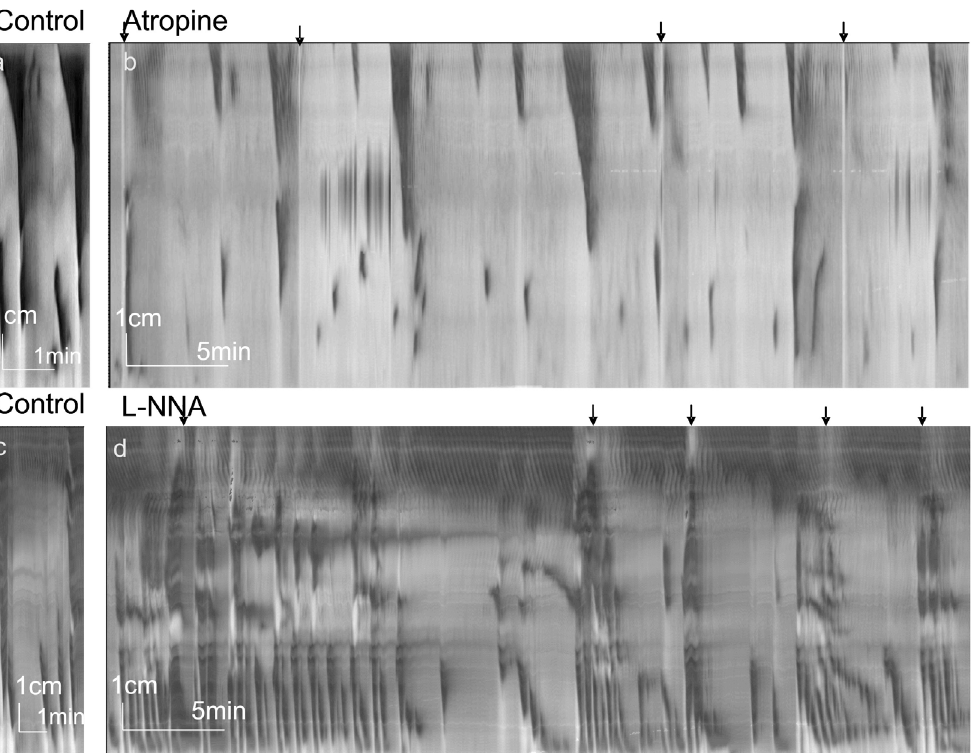
Figure 5. Atropine and L-NNA. Spatiotemporal maps created from video recordings of motor patterns of the whole rat colon. All arrows indicate infusion of PBS into proximal colon. a. Control LDCs with distal RPMCs. b. After addition of atropine the LDCs were getting smaller and disappeared after 30 min. Atropine was added 3 min before start of panel b. c. Control LDCs with distal RPMCs. d. Typical LDCs were not seen after blockade of nitric oxide synthesis. Strong rhythmic contractile activity was always present showing various and varying patterns at frequencies that were higher compared to control activity. L-NNA was added 8 min before start of panel d.